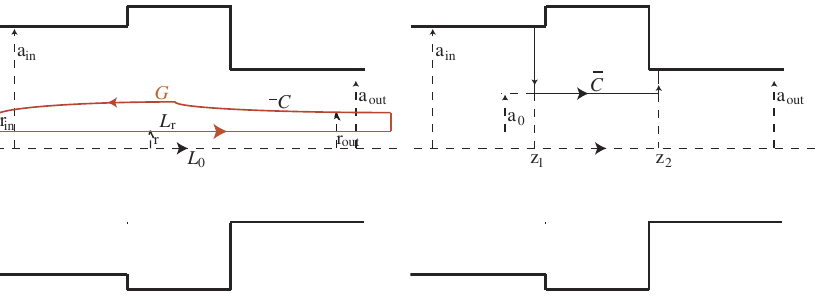
GENERALIZED NAPOLY INTEGRAL TO . .